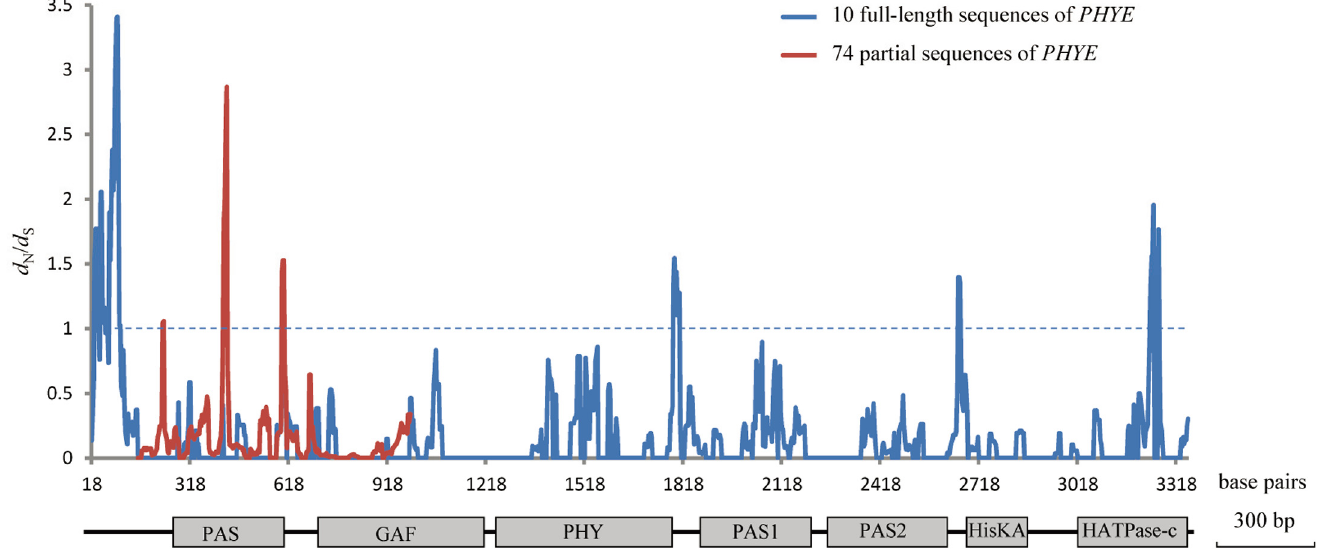
Fig 3. Sliding window analysis show variation of ω value along the PHYE gene from 74 partial sequences and 10 full-length sequences. The estimates were based on the Nei-Gojobori method. The window size was set at 30 bp and step size was set at 3 bp. Beneath the plot is a schematic of PHYE , which illustrates the distribution of the characteristic functional